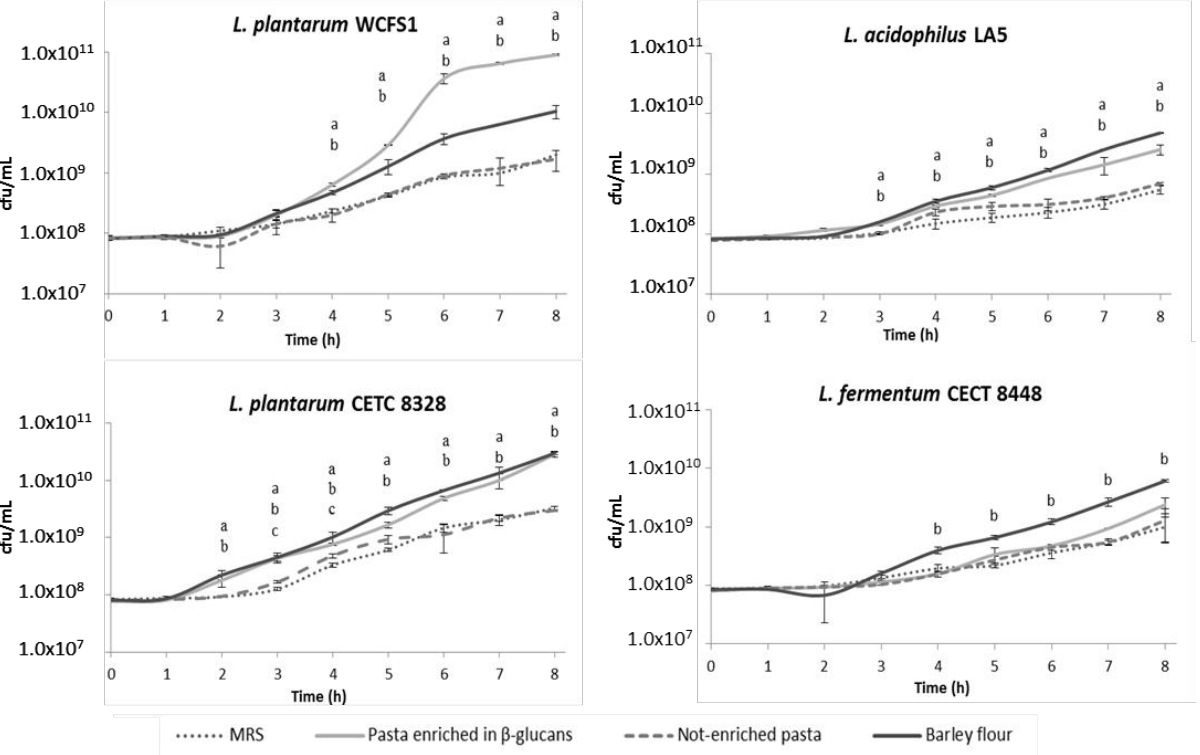
Figure 1. Growth curves of L. plantarum WCFS1, L. acidophilus LA5, L. plantarum CETC 8328 and L. fermentum CECT 8448. Bacteria were grown in MRS and MRS supplemented with different food matrices (not-enriched pasta, β-glucans enriched pasta and barley flour). Values represent mean ± standard deviation of three different experiments. relative to MRS (positive control). a p < 0.005 for samples cultivated in MRS supplemented with barley flour; c p < 0.005 for samples cultivated in MRS supplemented with not-enriched